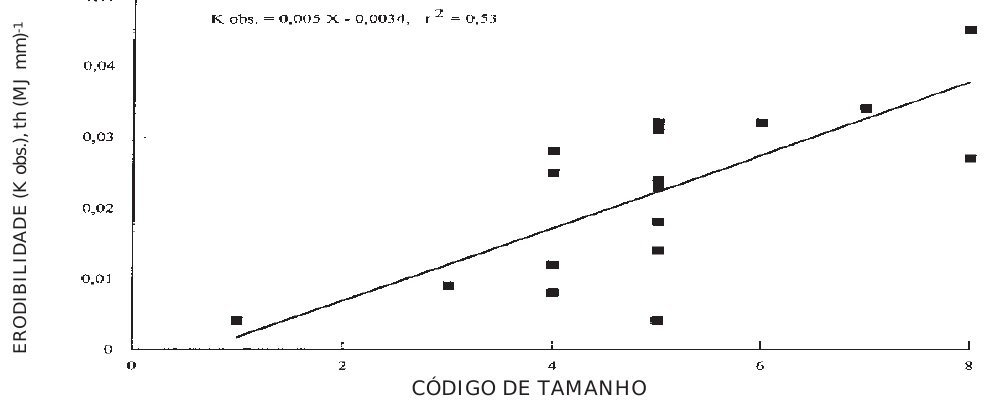
Figura 2. Relação entre o código do tamanho das unidades estruturais e o fator K observado (K obs.).